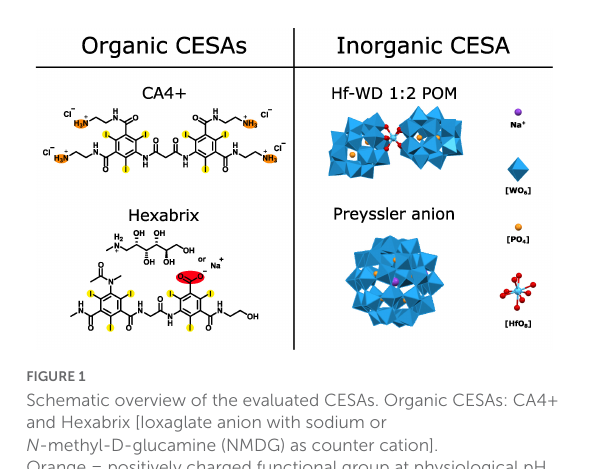
FIGURE1 Schematic overview of the evaluated CESAs. Organic CESAs: CA4+ and Hexabrix [Ioxaglate anion with sodium or N -methyl-D-glucamine (NMDG) as counter cation]. Orange = positively charged functional group at physiological pH, red = negatively charged functional group at physiological pH and yellow = heavy atom. Inorganic CESAs: Hf-WD 1:2 POM, Preyssler anion and POM building blocks. Heavy atoms are Tungsten (W) and Hafnium (Hf).